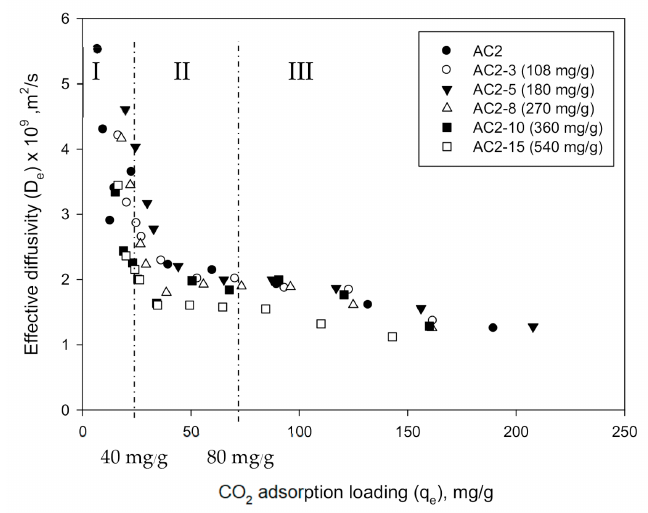
Figure 15. Effect of CO 2 adsorption loading (q e ) on the effective pore diffusivity of CO 2 (D e ) for AC2 activated carbon impregnated with varying NaOH